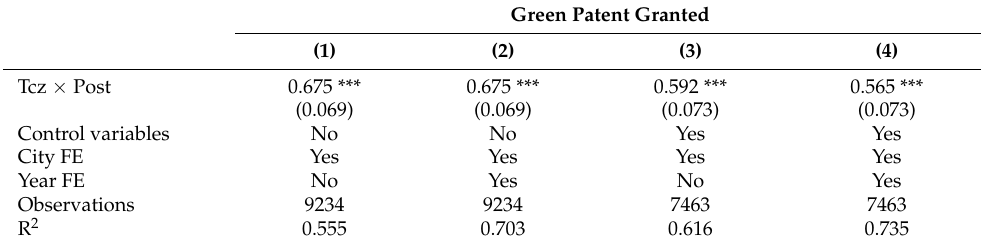
Table 4. The effect of TCZ policy on green patents granted.